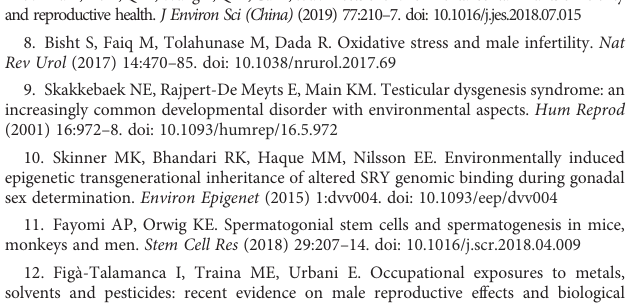
SUPPLEMENTARY FIGURE 1 Characterization of cultured SCs in vitro by fl uorescence microscopy. (A) SCs after immunostaining with AMH and (B) vimentin antibodies and visualized by anti-goat Alexa Fluor 488 (green). (C) SCs after immunostaining with 3- b HSD antibody and visualized by anti-rabbit Alexa Fluor 488 (green). (D) SCs after immunostaining with ASMA antibody and visualized by anti-rabbit Alexa Fluor 488 (green). Nuclei are counterstained with DAPI (blue). The images are representative of three separate